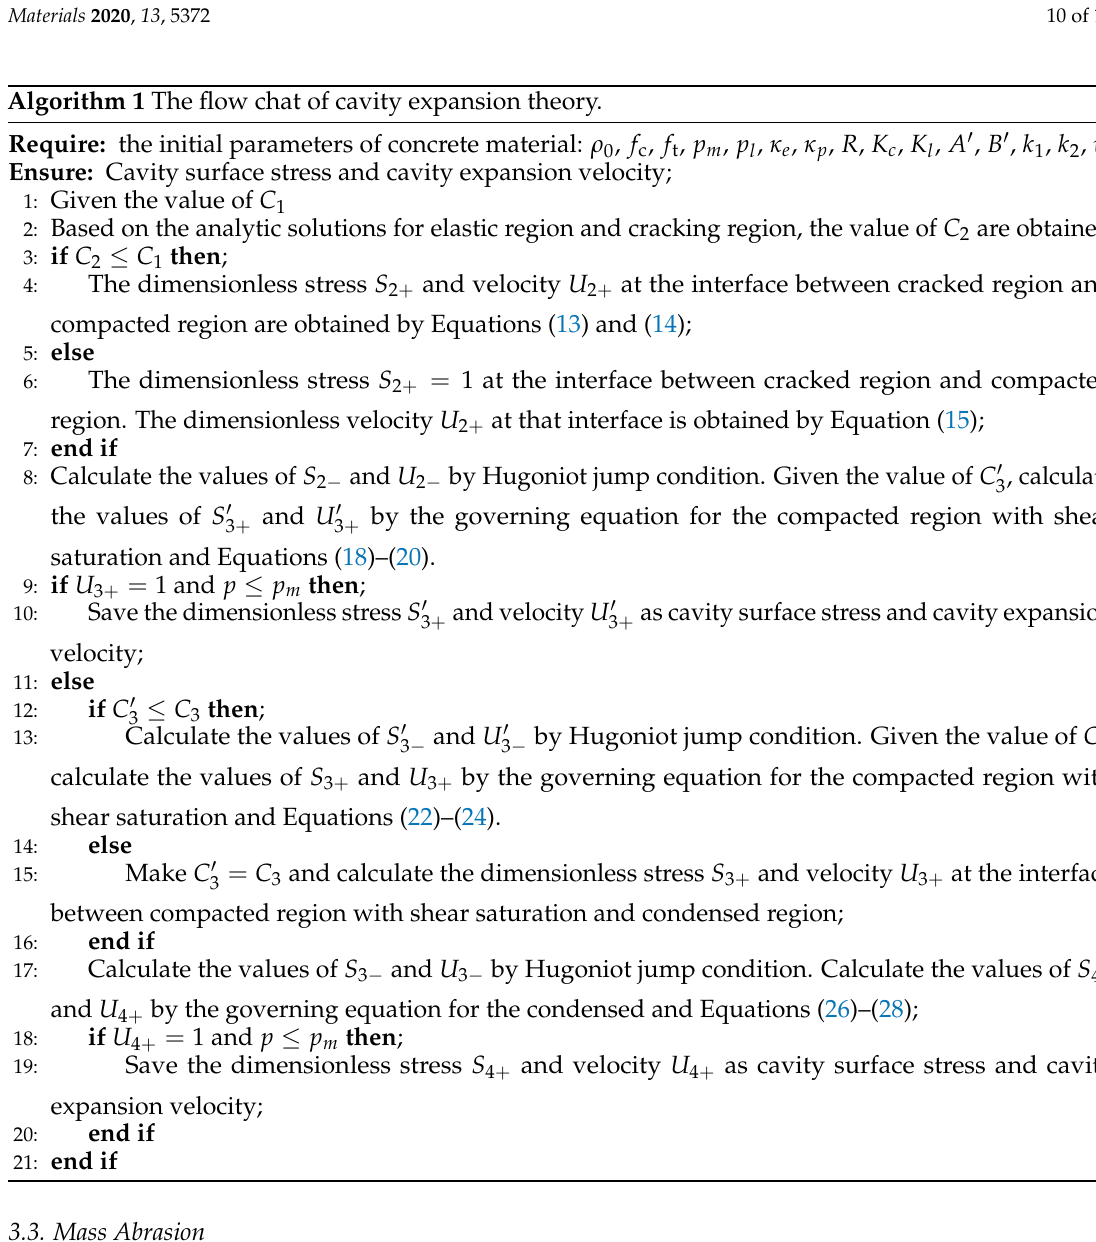
Algorithm 1 The flow chat of cavity expansion